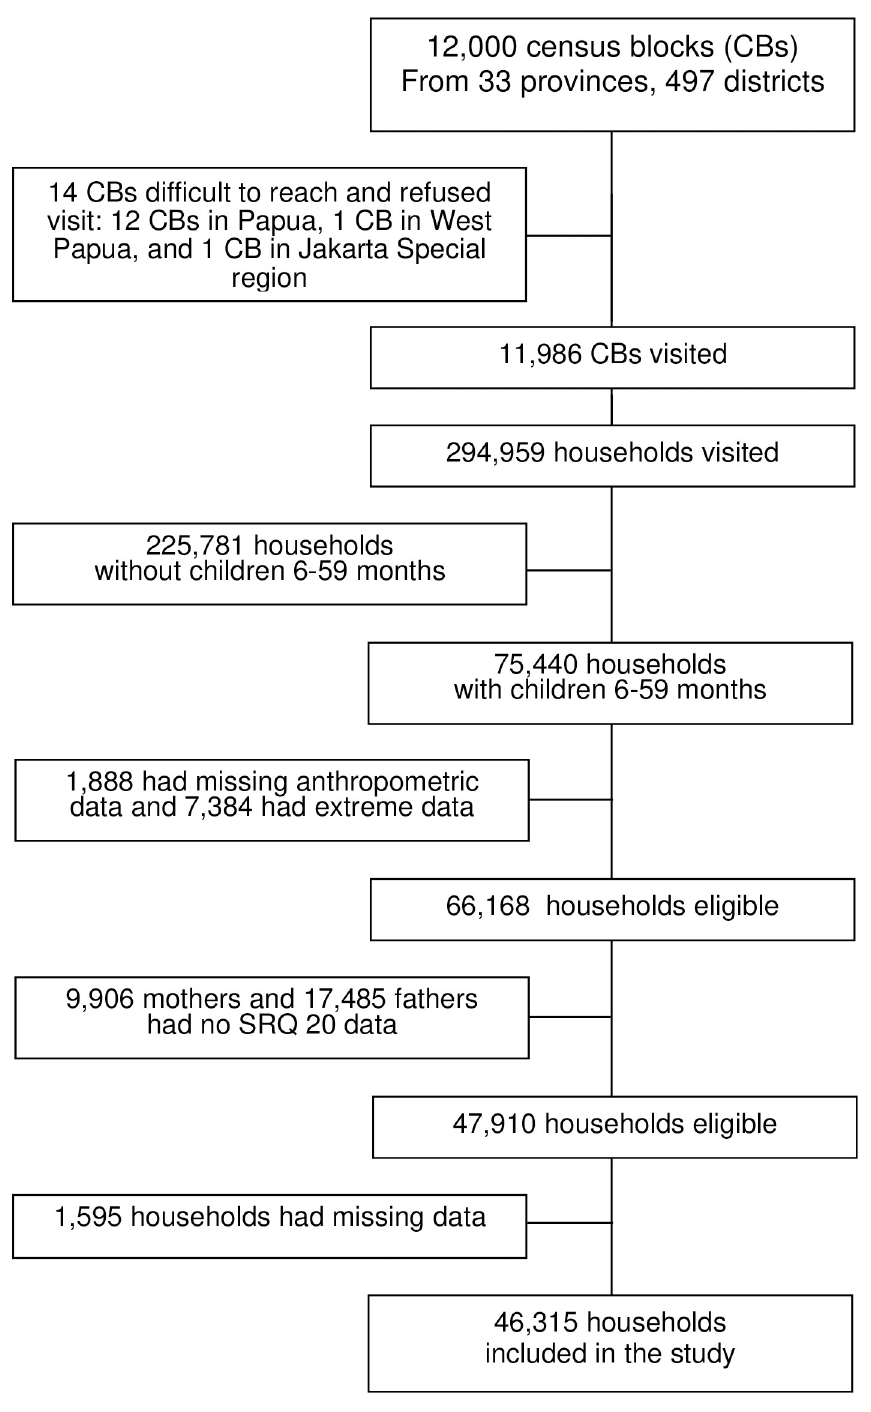
Fig 2. Flow diagram of participant